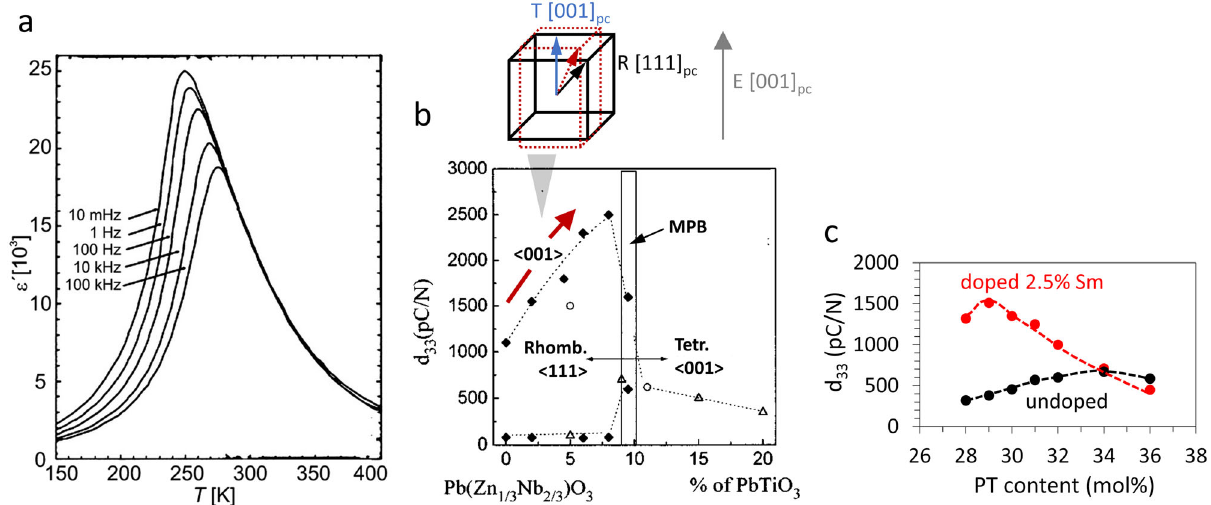
Fig. 1 Dielectric signatures and large piezoelectric response of lead-based RE-FE single crystals and ceramics. a Frequency dispersion of the temperature-dependent dielectric permittivity ( ε ’ ) maximum of PMN single crystal, representing the characteristic feature of RE-based materials 1,3 . b Piezoelectric d 33 coef fi cient of RE-FE Pb(Zn 1/3 Nb 2/3 )O 3 – PbTiO 3 (PZN-PT) single crystals as a function of composition (PT content) and orientation (with respect to applied electric fi eld), illustrating the large response of <001> -oriented rhombohedral (R) crystals close to the morphotropic phase boundary (MPB) region 7 (see red arrow). The source of the d 33 data is reported in the original paper (Ref. 7 ). The upper inset shows schematically the mechanism responsible for the large response, i.e., the easy rotation of the R [111] pc polarization vector (pc denotes pseudo cubic) toward the tetragonal (T) [001] pc polar direction in the case of the electric fi eld (E) applied along [001] pc (see text for detailed explanation). c Piezoelectric d 33 coef fi cient of PMN – PT ceramics as a function of PT content for undoped and Sm-doped ceramic samples, illustrating the ultrahigh piezoelectricity achieved by Sm doping. The data for undoped and Sm-doped PMN – PT were reproduced from Kelly et al. 54 and Li et al. 12 , respectively. Figures shown in ( a ) and ( b ) were reprinted from Ref. 3 and Ref. 7 by permission from John Wiley & Sons and AIP Publishing,